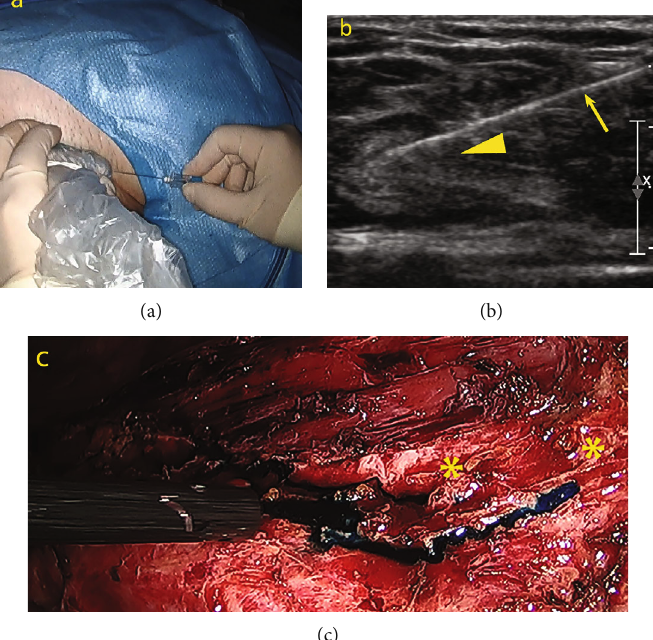
Figure 5: Identi fi cation of the point of chylous leakage. External (a) and ultrasound vision (b) of a transnodal injection of methylene blue under image guidance (lymph node, head arrow; needle, and arrow). Two leak points (stars) can be observed in the retroperitoneum (c) after seven minutes of percutaneous administration of methylene